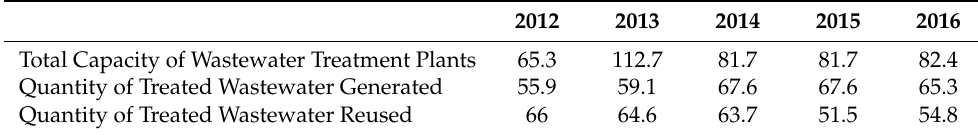
Table 2. Quantity of Wastewater Produced and Reused in Al Ain (hm 3